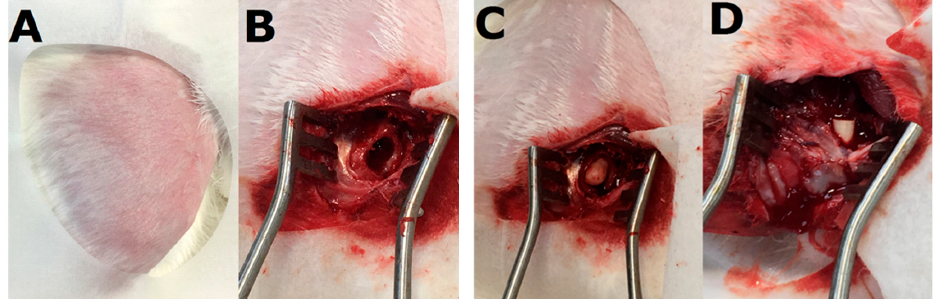
Figure 2. Images of the surgical procedure. ( A ) The right femoral site was depilated and sterilized. ( B ) a bone cavity was formed (5.0 × 10.0 mm 2 ); ( C ) a polymethylmethacrylate spacer was placed into the bone cavity; ( D ) after 2 weeks, fluconazole-impregnated Poly( D , L -lactide- co -glycolide) cylindrical beads (5.0 × 6.0 mm 2 ) were placed into the right femoral bone cavity.